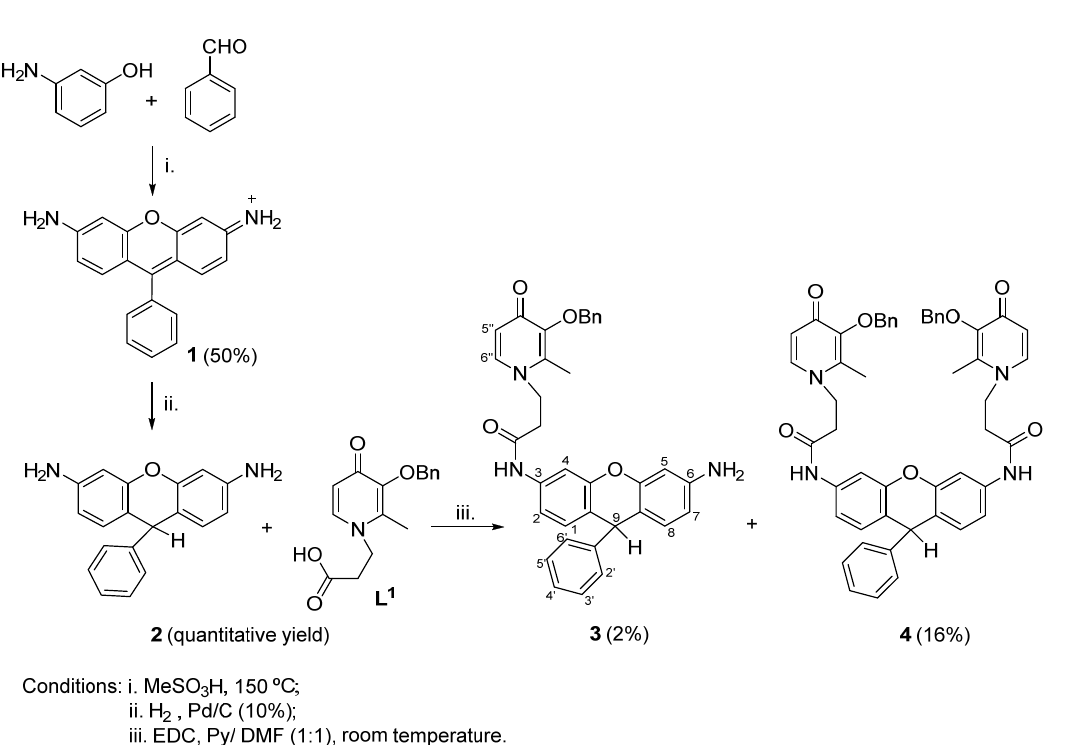
Molecules 2022 , 27 , x FOR PEER